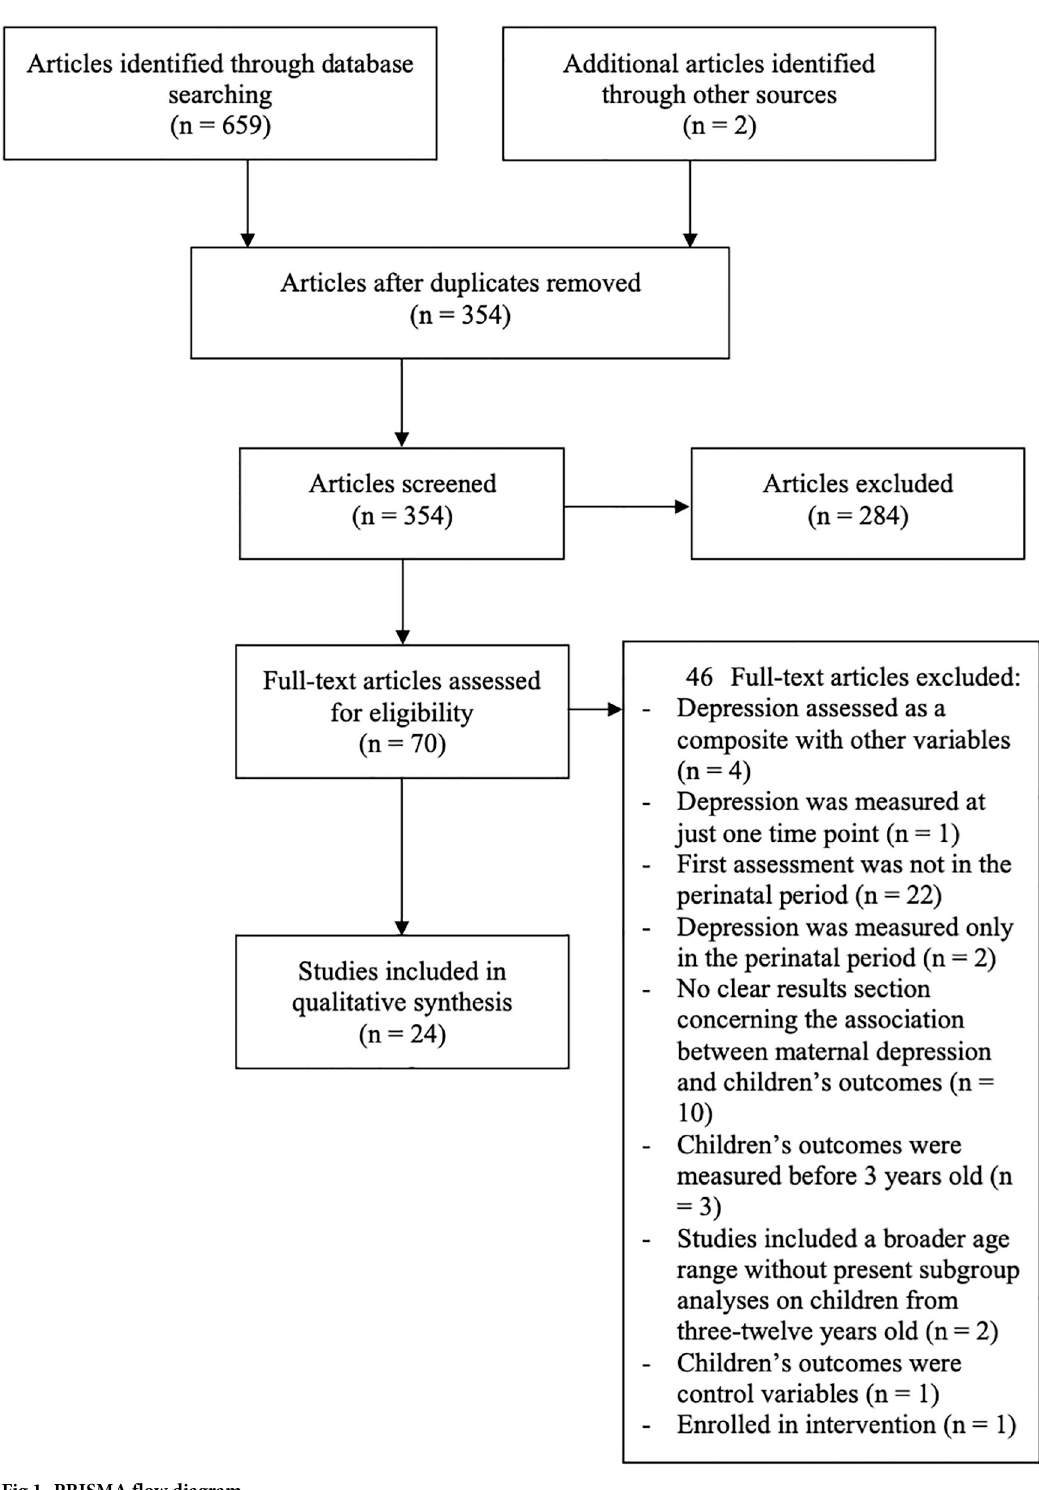
Fig 1. PRISMA flow